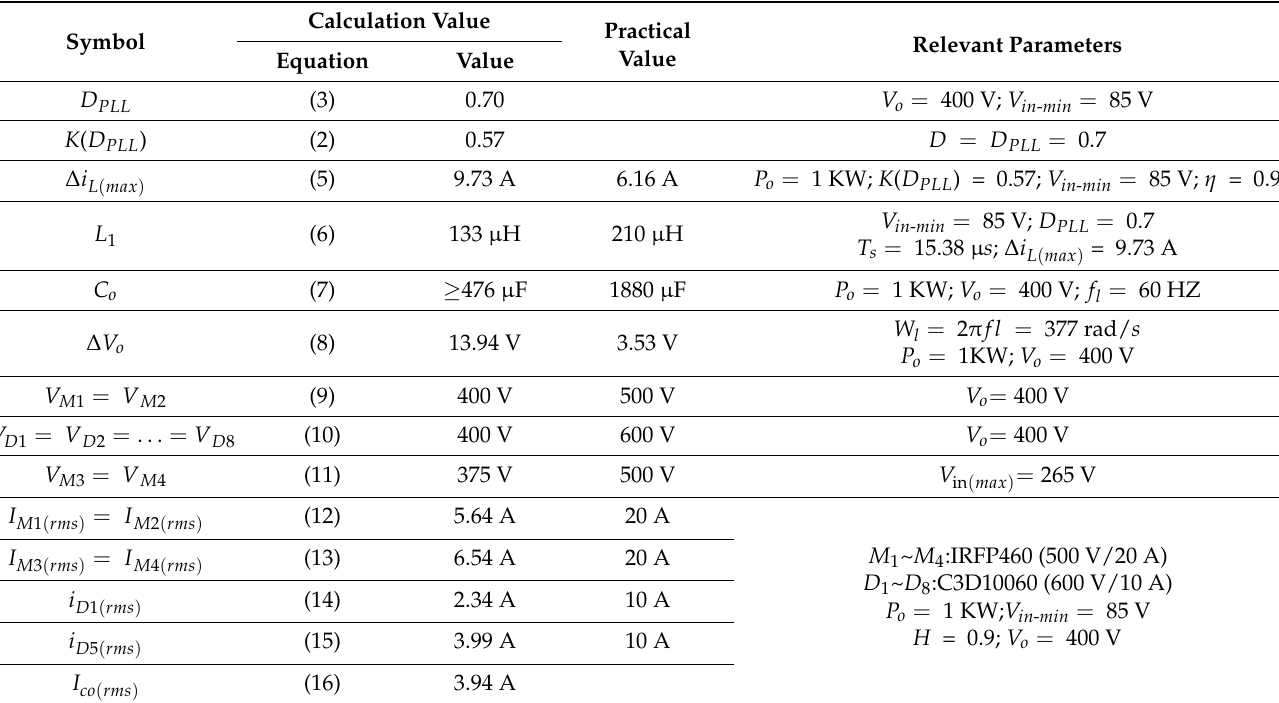
Table 2. Parameters of components in the proposed boost